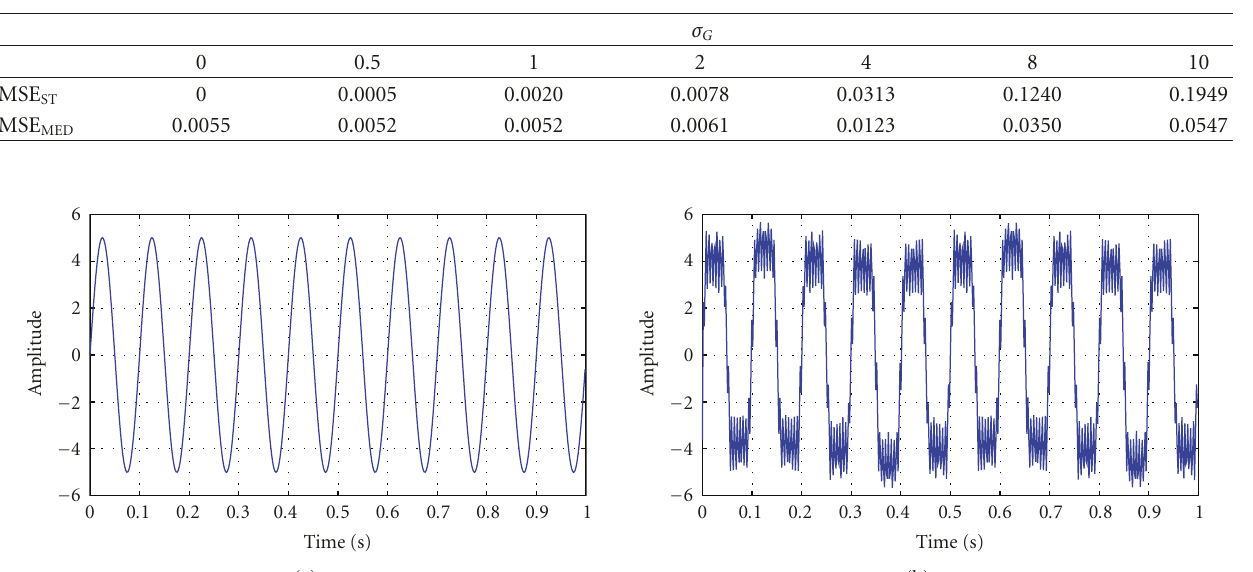
Table 1: MSE for signal s 1 ( n ) spectrum estimates obtained by standard DFT and RDFT method based on MED for the case of Gaussian noise with di ff erent values of σ G .